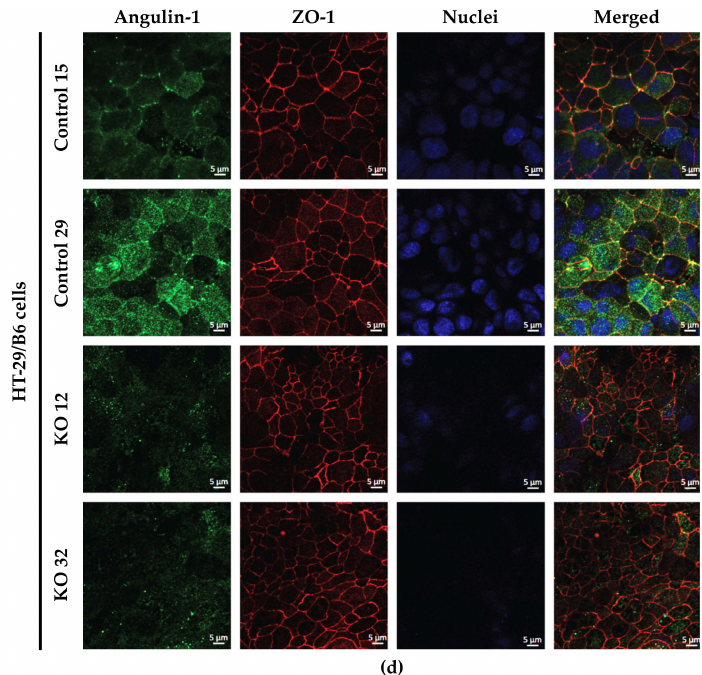
Figure 1. Expression and localization of angulin-1 in MDCK C7 and HT-29/B6 cells. Densitometric analysis of angulin-1 protein expression levels in control and angulin-1 knockout ( a ) MDCK C7 and ( b ) HT-29/B6 cells. sgRNA targeting angulin-1 led to a high decrease in angulin-1 expression in both cell lines ( n = 9, MDCK C7: *** p ≤ 0.001 with regard to control 14 and ### p ≤ 0.001 with regard to control 18 and HT-29/B6: *** p ≤ 0.001 with regard to control 15 and ### p ≤ 0.001 with regard to control 29). Immunostaining of angulin-1 in the clones used throughout this study in ( c ) MDCK C7 and ( d ) HT-29/B6 cells. In the KO clones of both cell lines, angulin-1 disappeared from the tTJ in comparison with their controls. Angulin-1: green; Occludin or ZO-1: red; DAPI (nuclei):